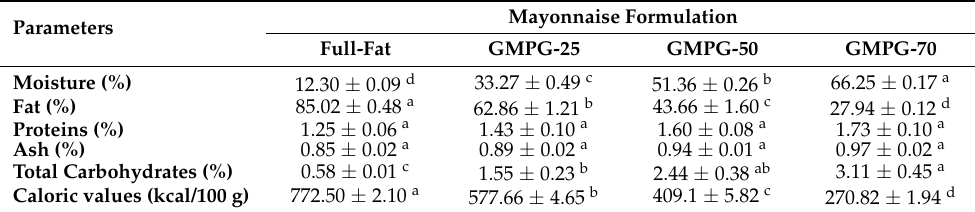
Table 3. Proximate analysis (%, w / w ) and caloric values of mayonnaise samples at different fat